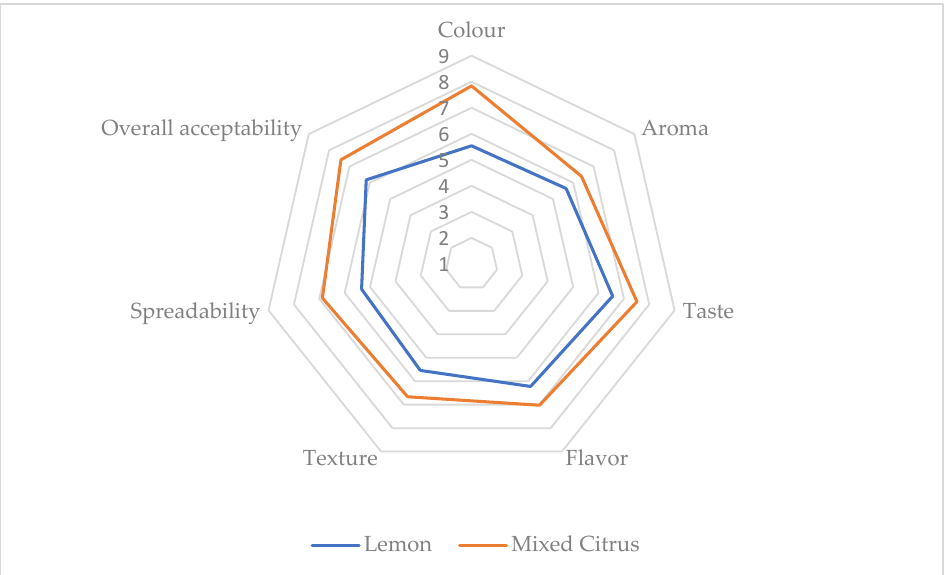
Figure 5. Radar graph of sensory analysis of Lemon and Mixed Citrus samples.